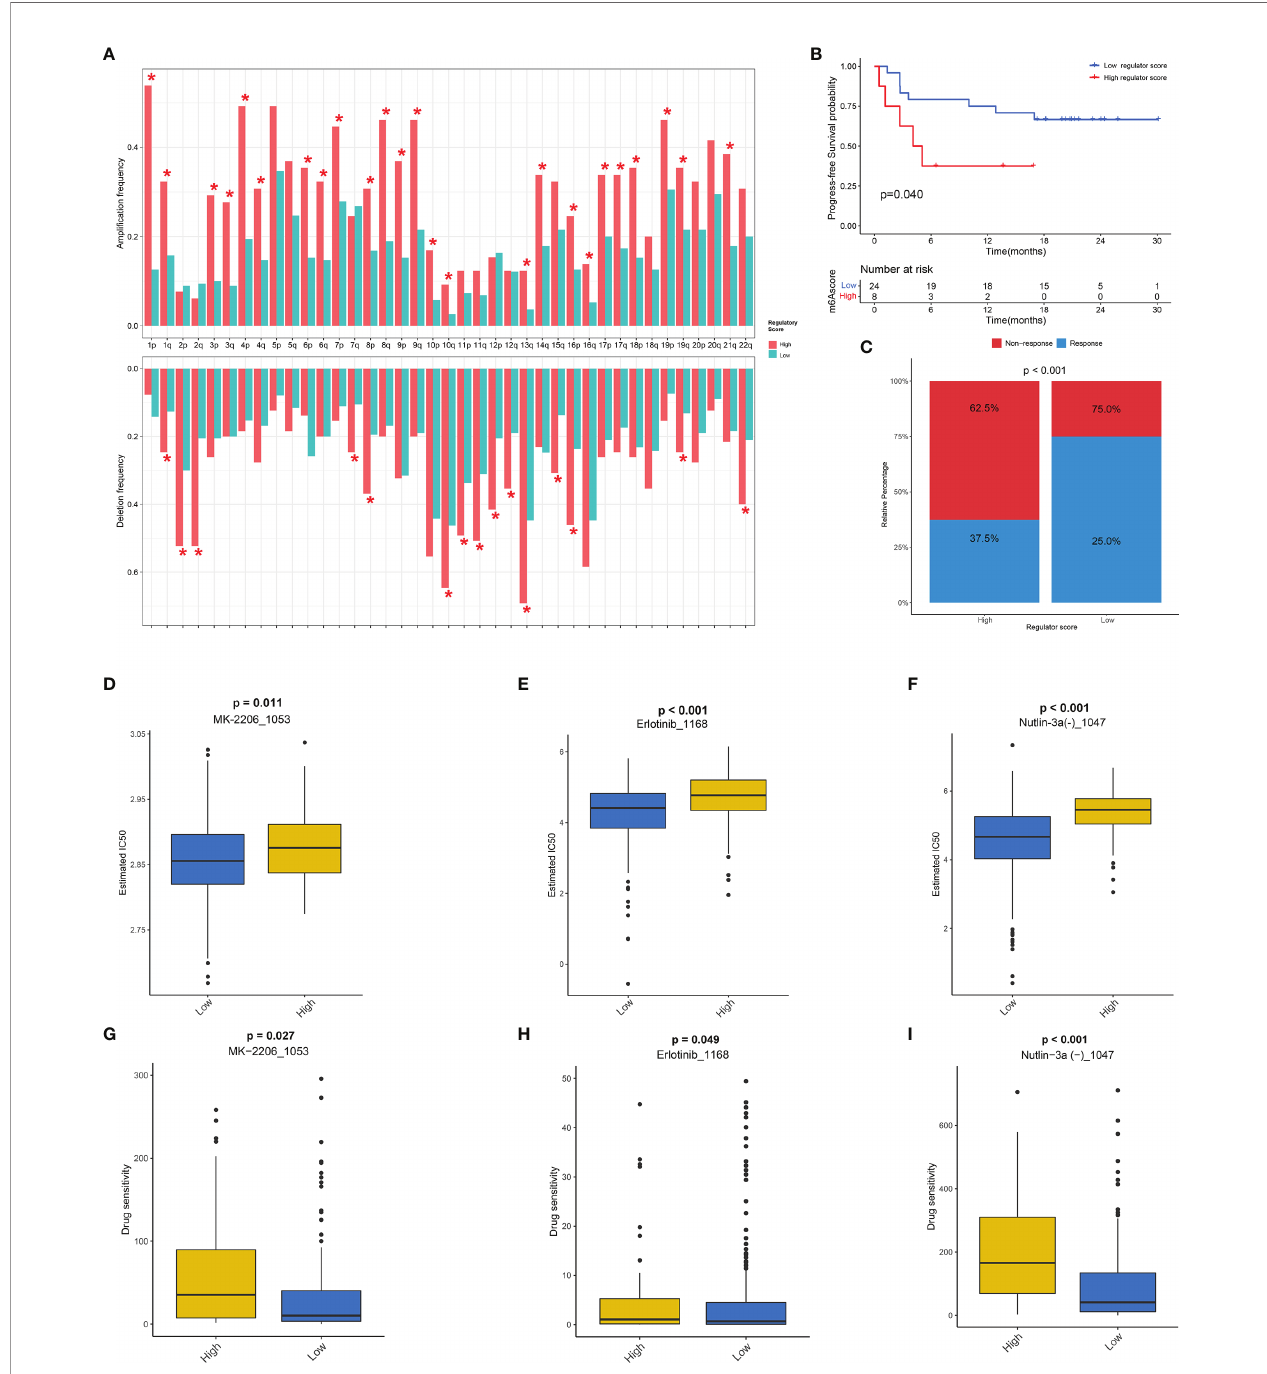
FIGURE 8 | The potential role of regulator score in CNV and chemotherapeutic value. (A) The frequency of arm-level ampli fi cation and deletion between low and high regulator score groups. (B) The progression-free survival (PFS) curve comparing survival of high and low regulator score groups in a cohort of melanoma patients treated with the combination of anti-PD-1 and anti-CTLA-4. (C) The proportion of clinical response to anti-PD-1 with anti-CTLA-4 immunotherapy in high and low regulator score groups in the melanoma cohort. (D – F) The box plot of the estimated IC50 of MK-2206 (D) , erlotinib (E) , and Nutlin-3a (F) between low and high regulator score groups. (G – I) The box plot of the predicted drug sensitivity scores of MK-2206 (G) , erlotinib (H) , and Nutlin-3a (I) between low and high regulator score groups. A lower drug sensitivity score indicated that this group could be more sensitive to the drug therapy. *, p <